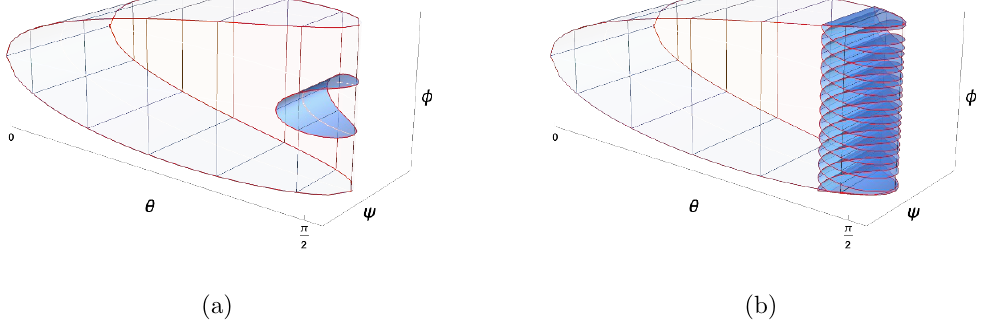
Figure 6. SU(2) branes. The SU(2) group manifold is depicted in Euler angles as the (cid:30) -